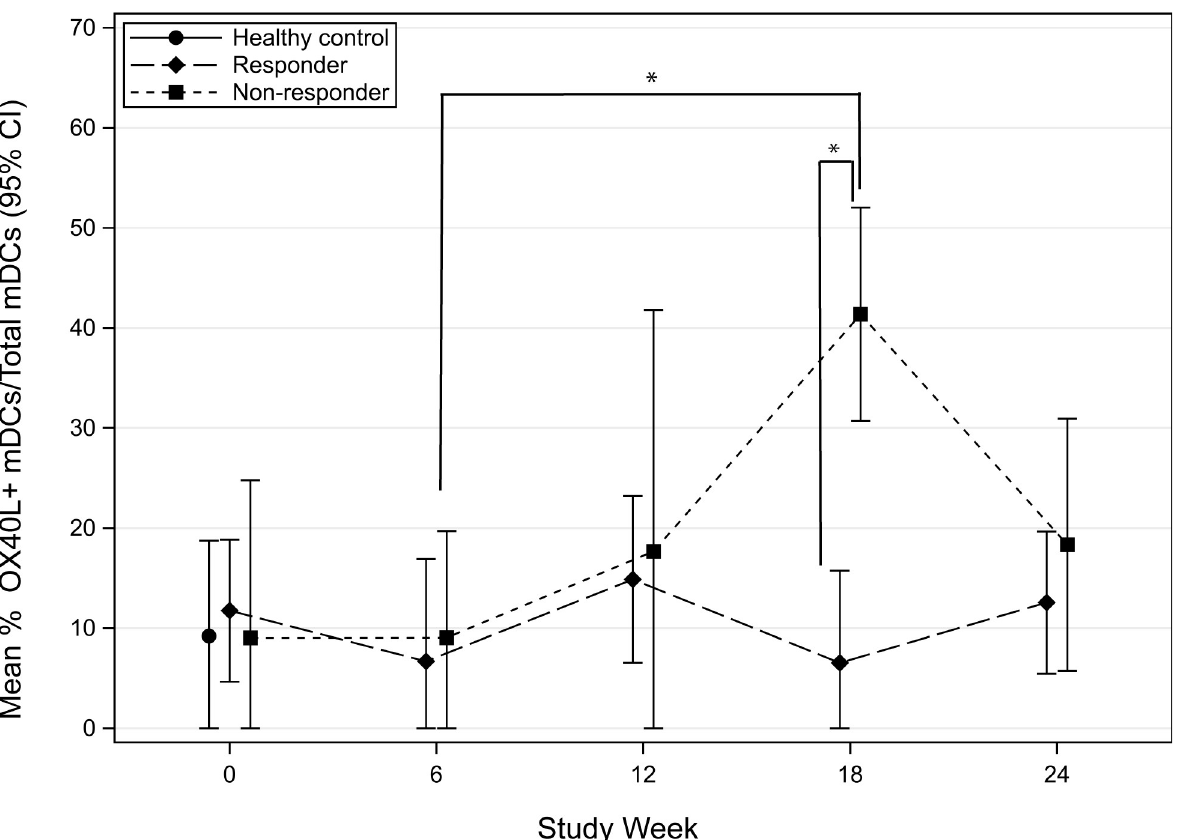
Fig 5. Mean percent frequency (95% CI) of OX40L myeloid dendritic cells (mDCs) following LPS stimulation in the 1 st 24-weeks in POIT responders and non-responders.